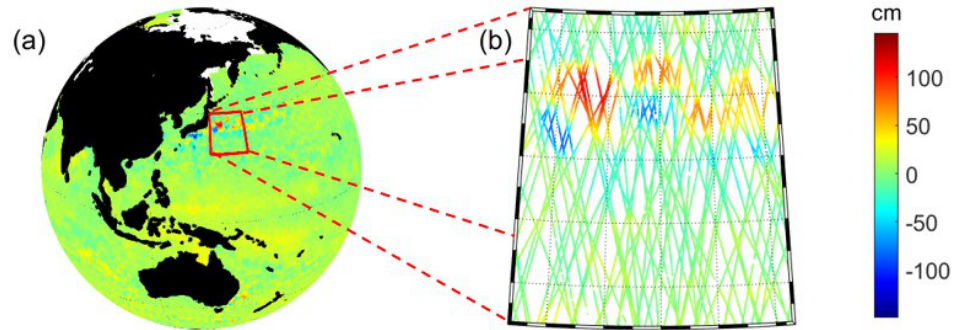
Figure 2. ( a ) The geographic location of the study area. ( b ) distribution of the along-track data. Table 1. Descriptive introduction to the SLA data. Sample